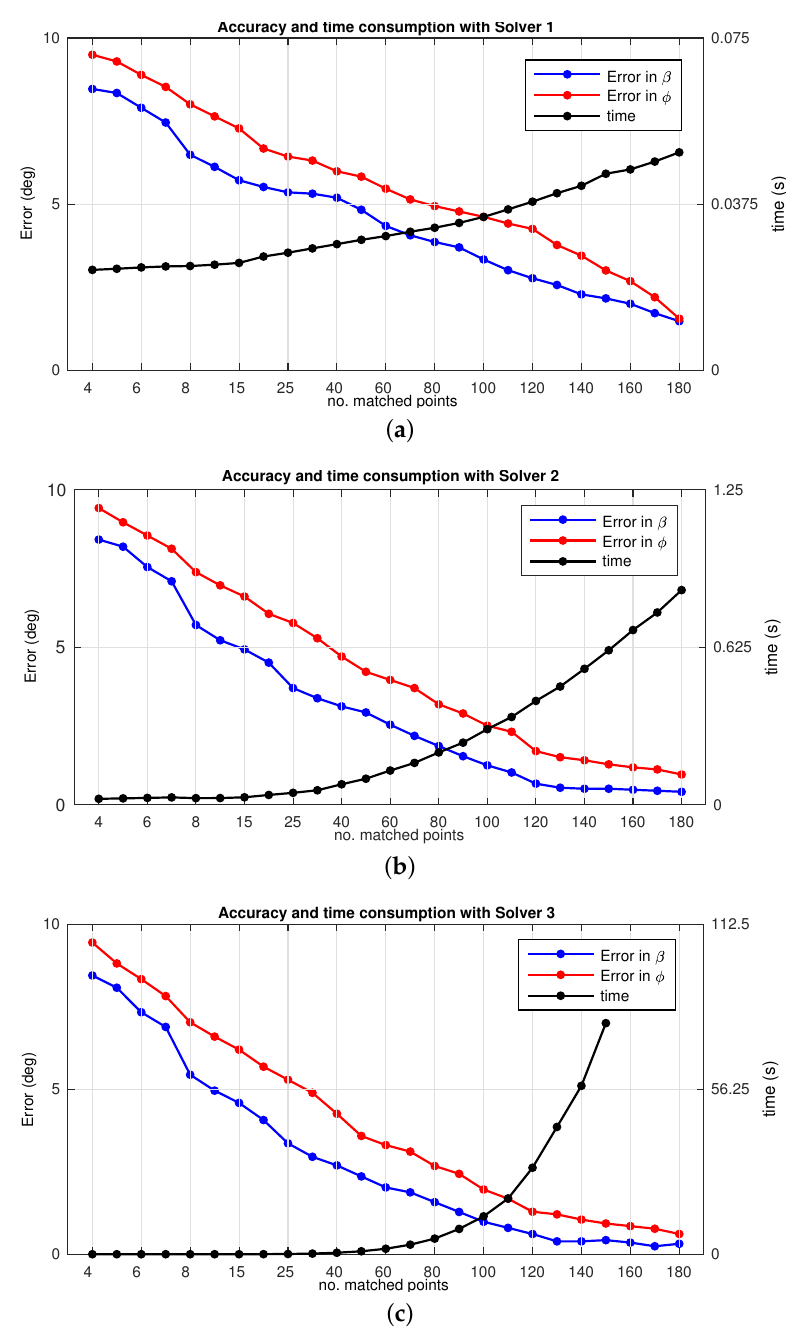
Figure 17. Time consumption and error in ( β , φ ) versus the number of matched points: ( a ) Solver 1; ( b ) Solver 2; ( c ) Solver